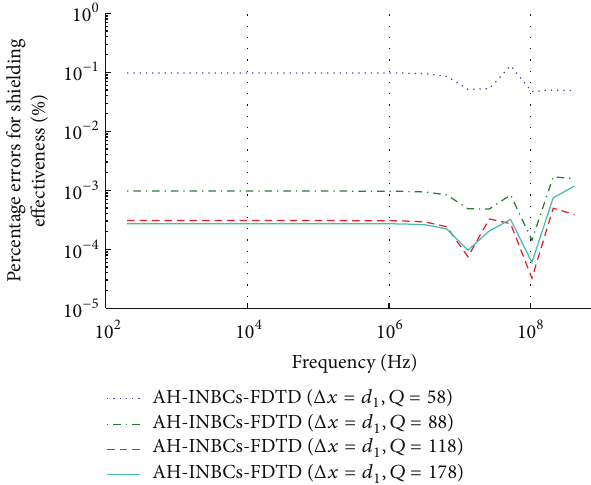
directly reconstructed using the unique time-frequency iso- morphism feature of AH basis. The proposed method has advantages over conventional FDTD in saving CPU time and avoiding the CFL constrains. The numerical accuracy can also be guaranteed for the relative larger CFLN. Although the proposed formulation is presented in 2D case, it can be combined with 3D AH-FDTD formulation to deal with three- dimensional problems in